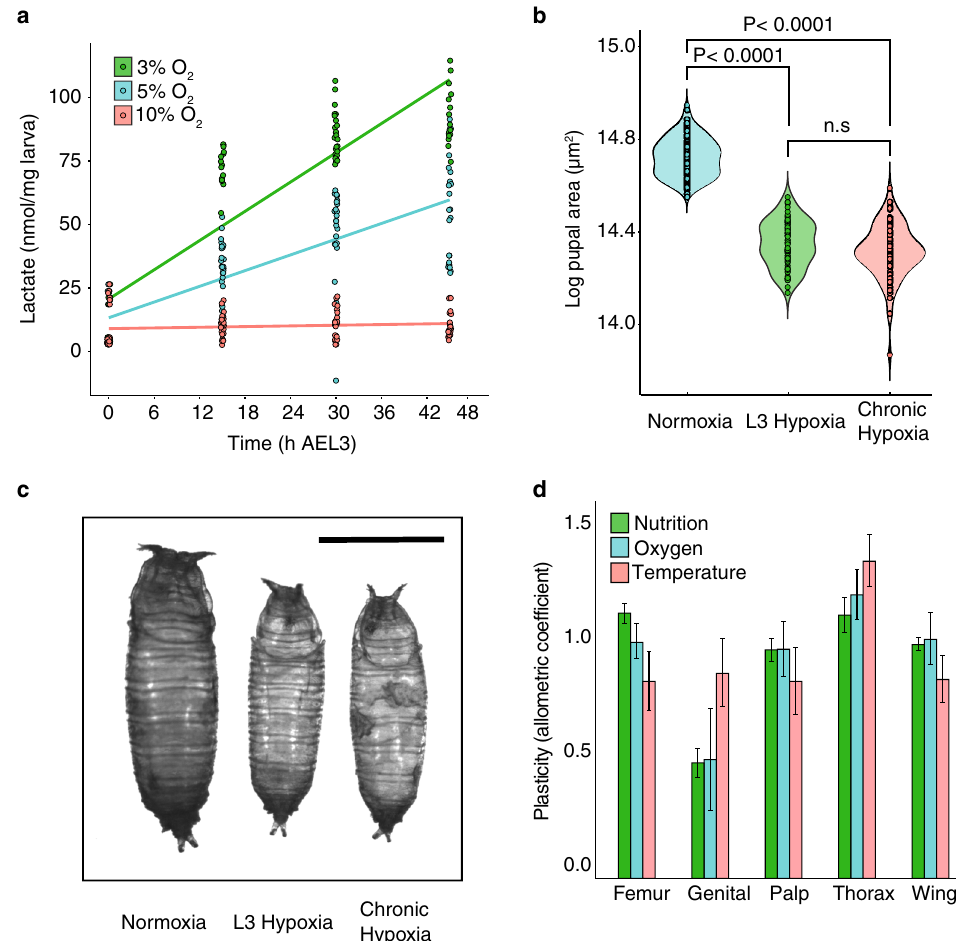
Figure 1. Moderate hypoxia suppresses growth without limiting aerobic respiration and in a way that parallels the effects of low nutrition on growth. ( a ) Lactate accumulation in third instar larvae transferred to different oxygen levels. Transfer to 3% and 5% O 2 resulted in significant increase in lactate (OLS regression, P < 0.0001 for both). Transfer to 10% O 2 had no effect on lactate levels (OL regression, P = 0.1). ( b ) Final body size (pupal case area) is reduced relative to normoxia when flies are reared in hypoxia throughout development (chronic hypoxia) or when reared in hypoxia only during the third larval instar (L3 hypoxia). Body size between treatments was compared using pooled t-tests. ( c ) Representative pictures of pupal cases of flies reared in normoxia, L3 hypoxia and chronic hypoxia. Black bar is 1 mm. ( d ) Relative plasticity of different traits to environmental variation in developmental nutrition, oxygen and temperature. The allometric coefficient captures the extent to which trait size varies relative to the body as a whole; that is, relative plasticity. An allometric coefficient of 1 indicates that the trait scales isometrically with overall body size. Error bars are 95% confidence